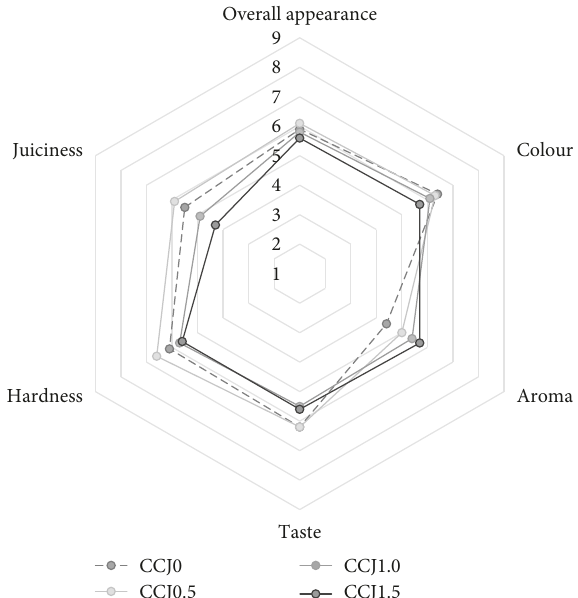
Figure 2: Sensory evaluation of beef burgers, n �